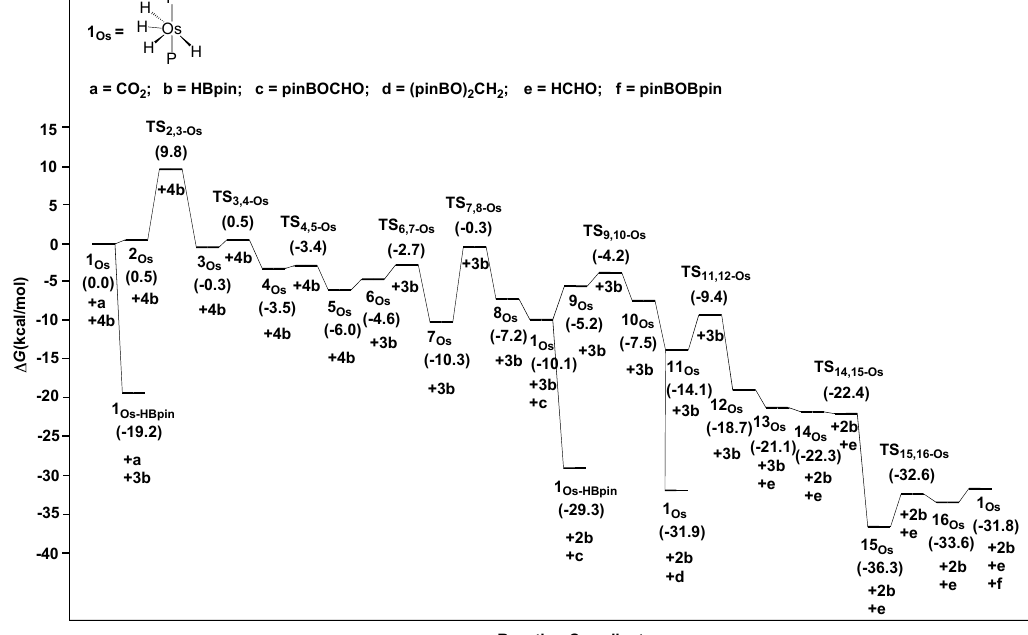
Figure 5. Free energies profile of the reduction of carbon dioxide to formaldehyde catalyzed by 1 Os .